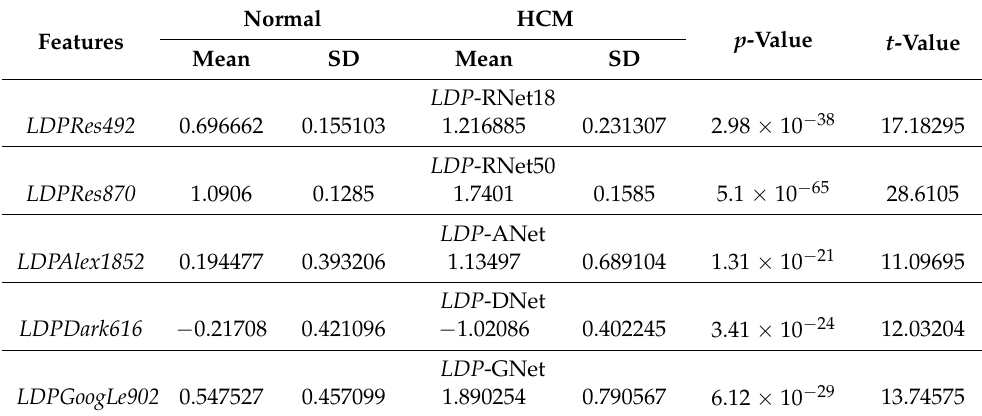
Table 4. Highest-ranked features using the various deep-learning